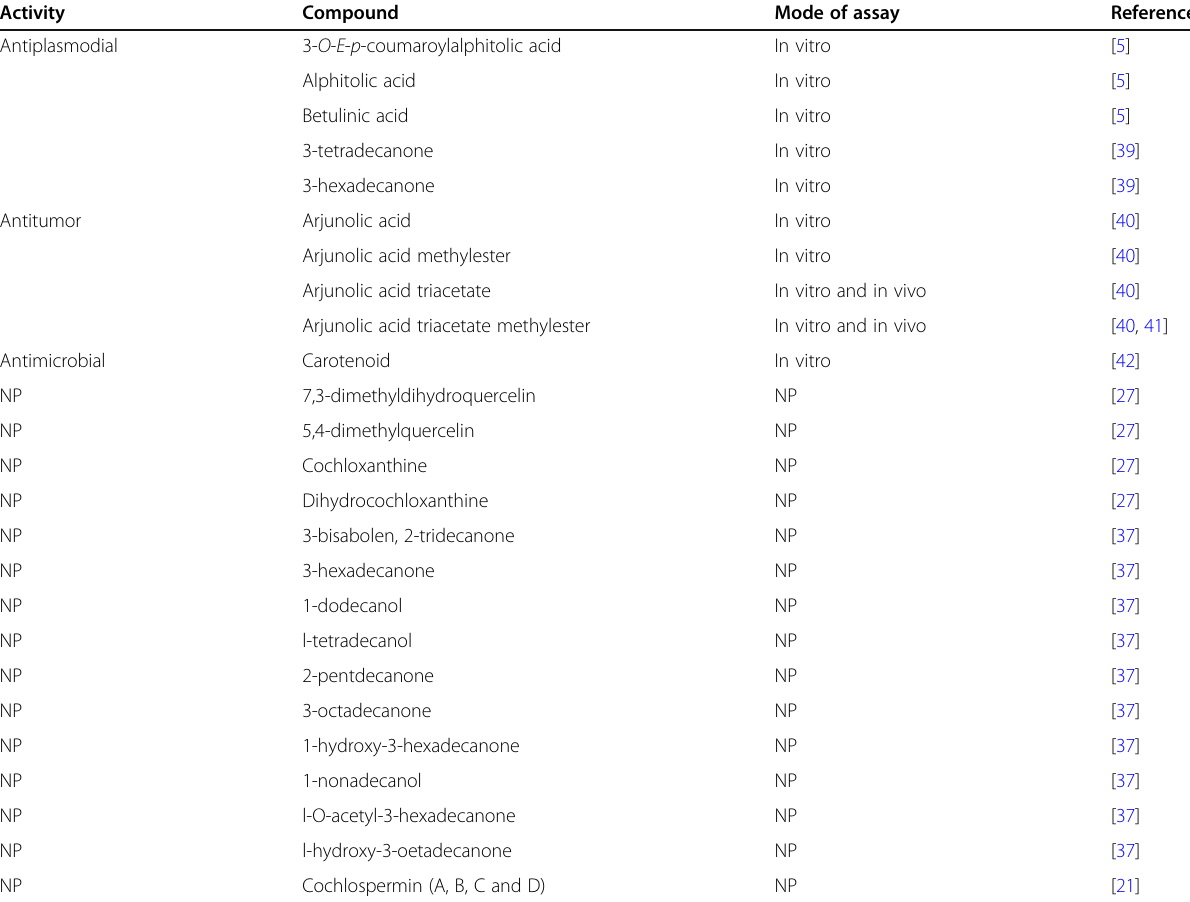
Table 2 Bioactive compounds isolated from Cochlospermum tinctorium and their pharmacological activities